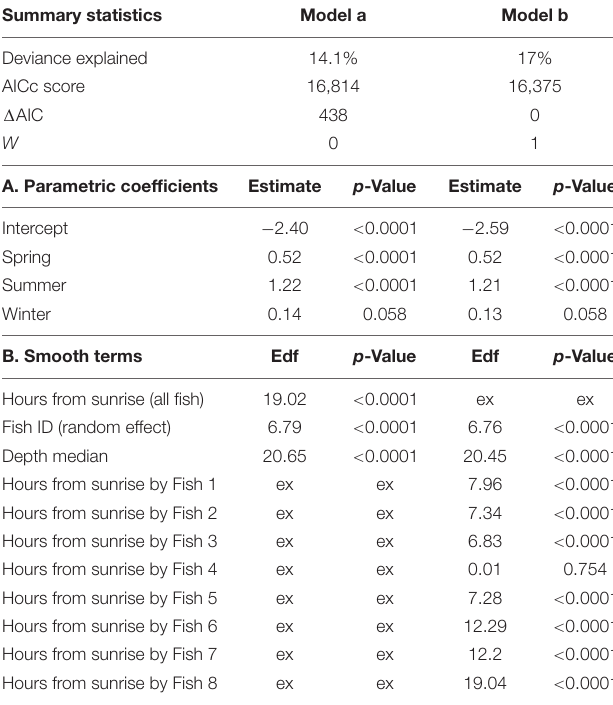
TABLE 2 | Summary of the GAMs fitted for the lionfish activity